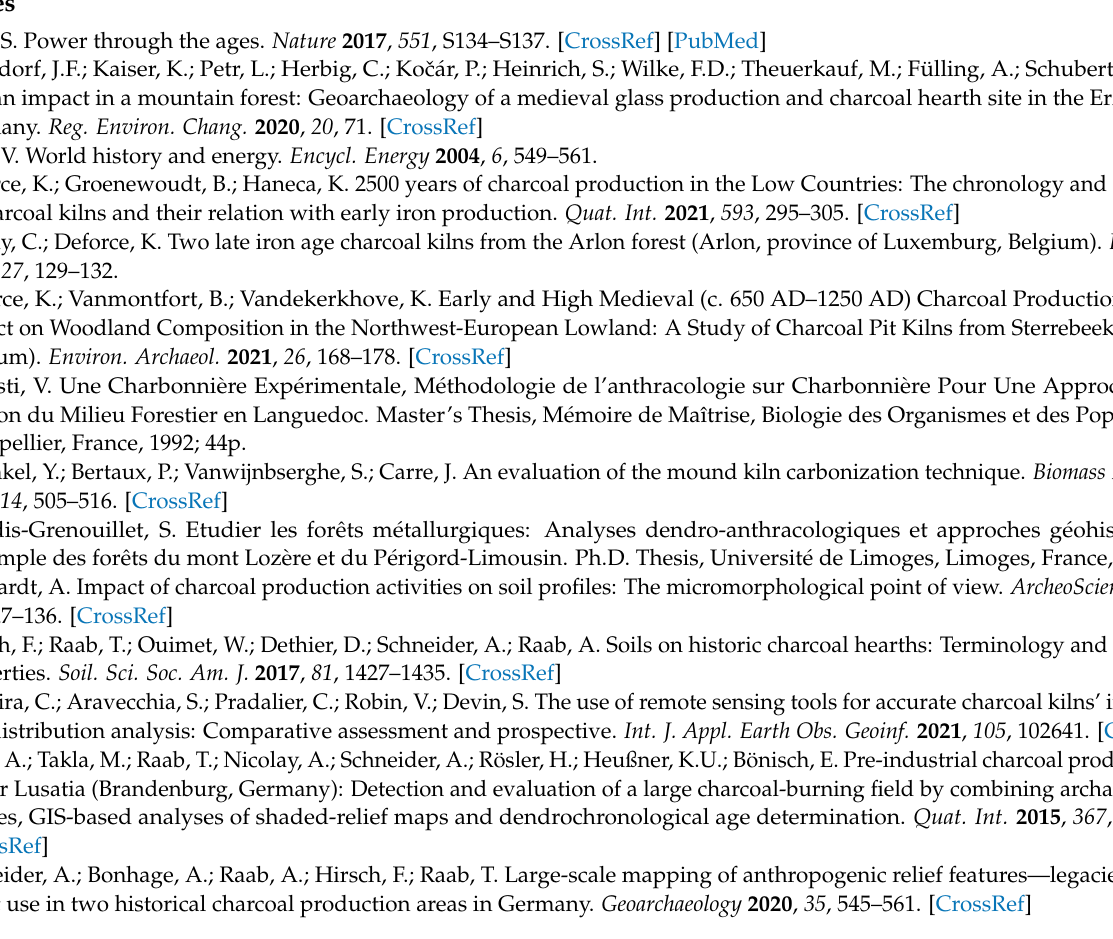
taxonomic identification by charcoal kiln. Table S3: Complete results of the diameter estimates (in absolute frequency), in decreasing order. Figure S1: Boxplot for the five community structure index according to the subsample location. Figure S2: Factorial planes of the COA on the kiln x